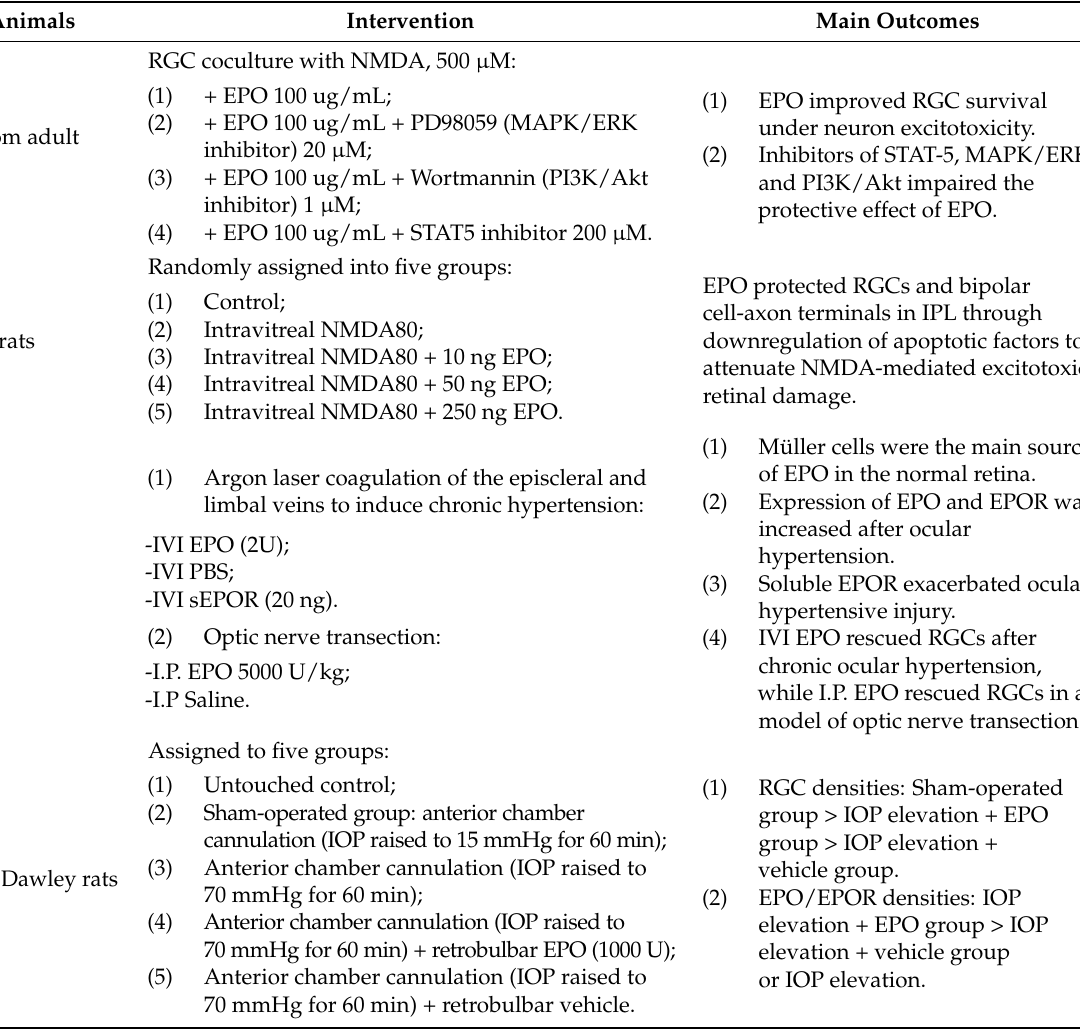
Table 1. Summary of studies that have evaluated erythropoietin for treatment of